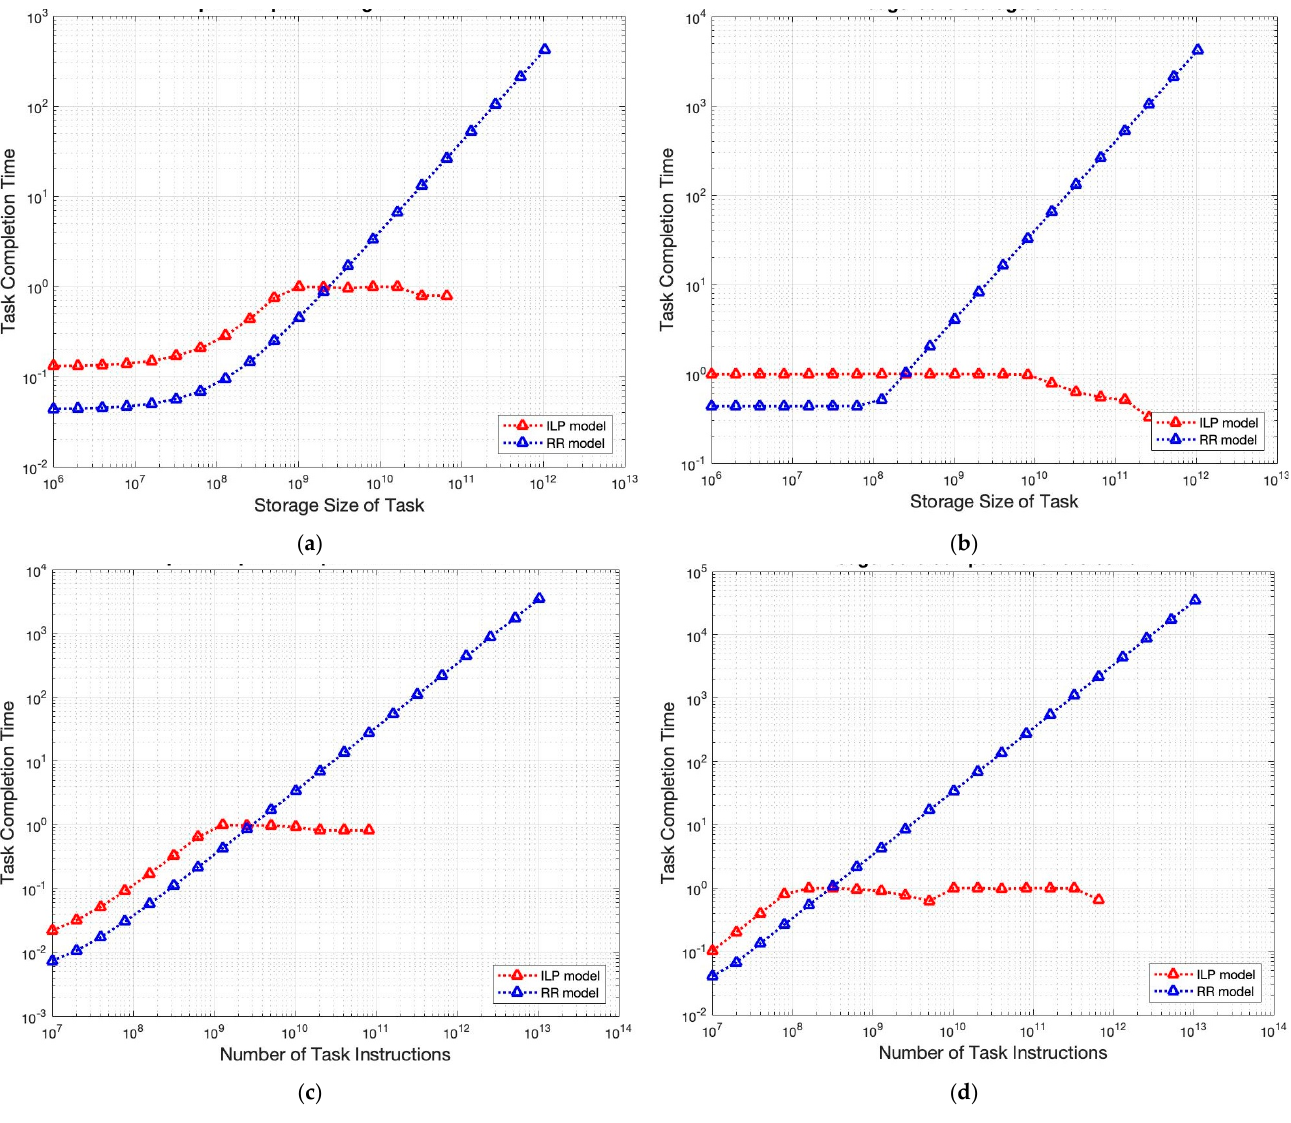
Figure 5. Task completion time: ( a ) peer-to-peer federated cluster scenario in case study 1; ( b ) edge-core cluster scenario in case study 1; ( c ) peer-to-peer federated cluster scenario in case study 2; ( d ) edge-core cluster scenario in case study 2.